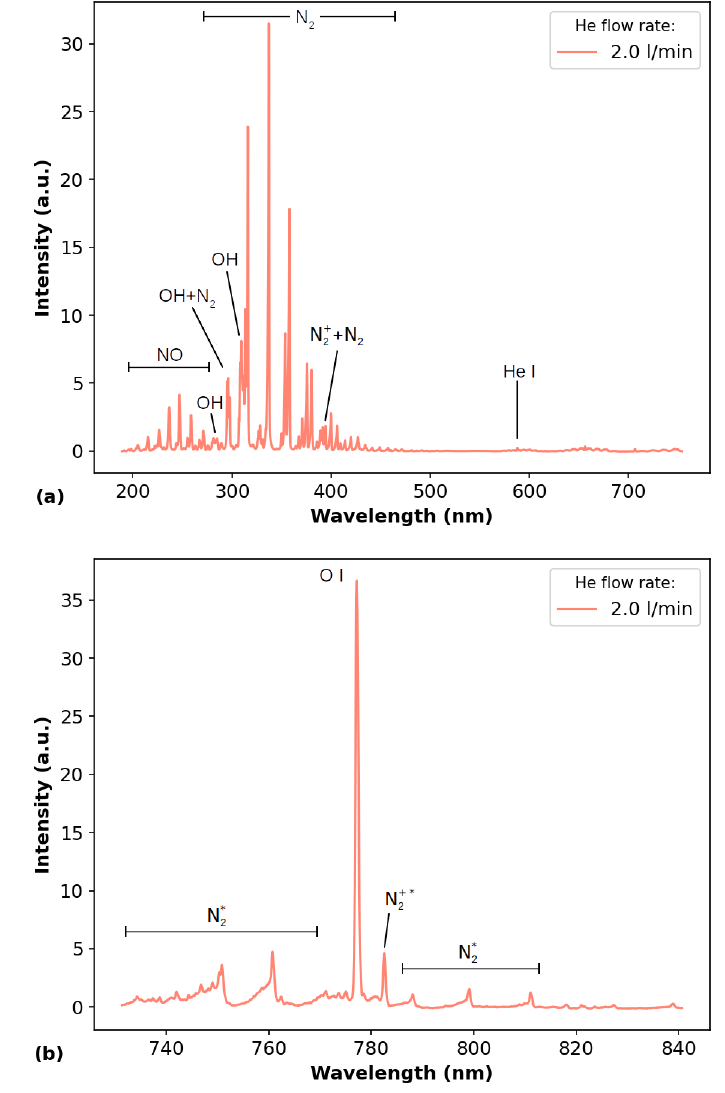
Figure 4. Overview of the emission spectrum of the plasma jet obtained using ( a ) the Avantes spectrometer and ( b ) the Horiba one with 2.0 L/min of He flow rate without additional O 2 . The distance between the plasma outlet and the target was d = 3 mm. The asterisks in the notations in ( b ) indicate second order emissions from N 2 and N + 2